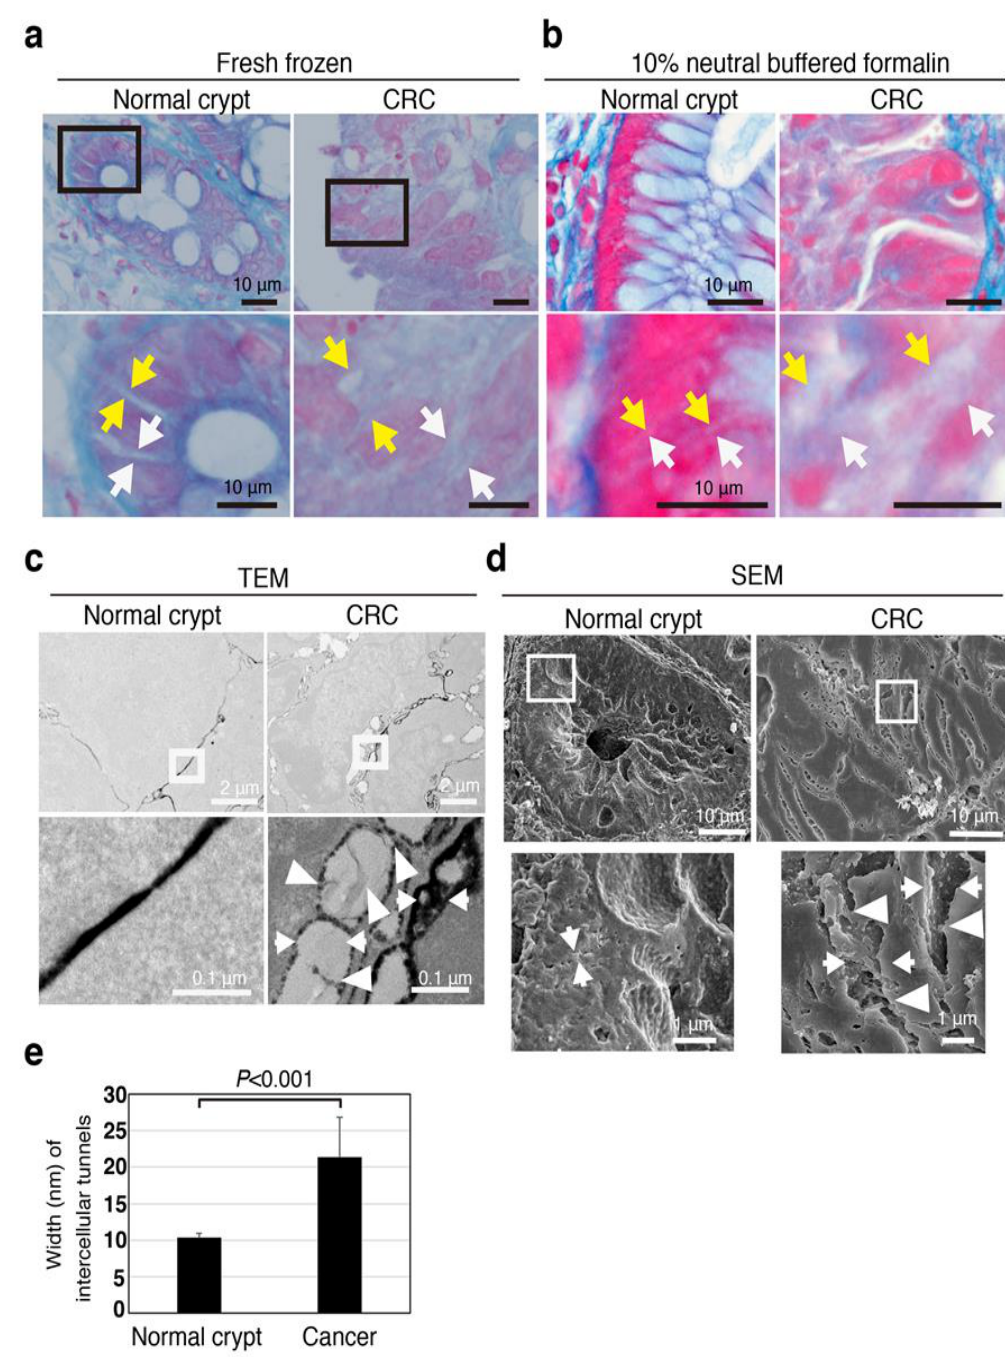
Figure 4. Intercellular tunnels are wide in human CRC tissues regardless of fixation procedure. ( a ) Images of Azan staining in fresh-frozen tissues (normal and cancer tissue) of a CRC patient. Arrows (both white and yellow) indicate the width of intercellular tunnels. ( b ) Images of Azan staining in 10% neutral buffered formalin-fixed tissues (normal and cancer tissue) of a CRC patient. Arrows (both white and yellow) indicate the width of intercellular tunnels. ( c ) TEM image with lanthanum nitrate of representative normal and cancer tissue. Arrows indicate the width of intercellular tunnels. Arrowheads indicate bridge-like ultrastructures. ( d ) SEM image with lanthanum nitrate of representative normal and cancer tissue. Arrows indicate the width of intercellular tunnels. Arrowheads indicate bridge-like ultrastructures. ( e ) Intercellular tunnels between cancer cells were wider than those between normal-appearing epithelial cells in TEM images with lanthanum nitrate. Error bars represent ± standard deviations of the average values.